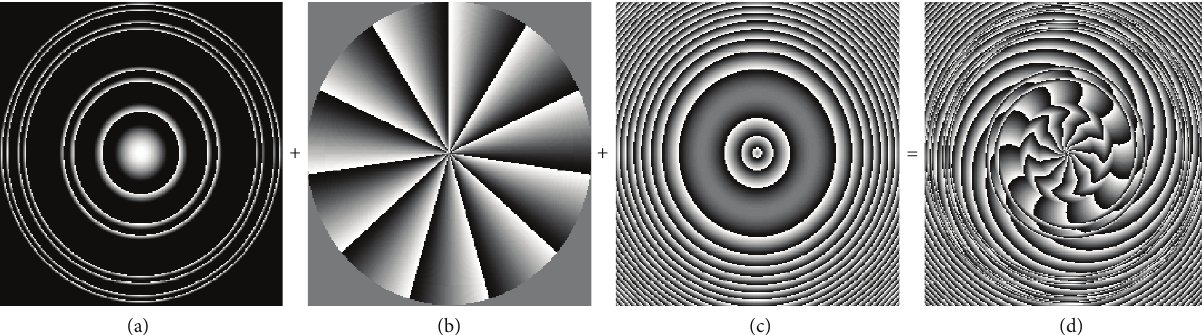
Figure 1: Phase plots of each component which when combined result in Devil’s vortex toroidal lens (DVTL); (a) DL for 𝑆 = 3 ; (b) VL for 𝑚 = 11 ; (c) TL; (d) DVTL.